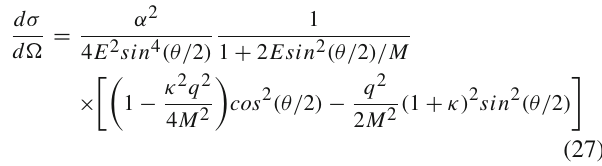
Fig. 7 Thedecayoftheinitialfluctuationisshowninlogscalebetween